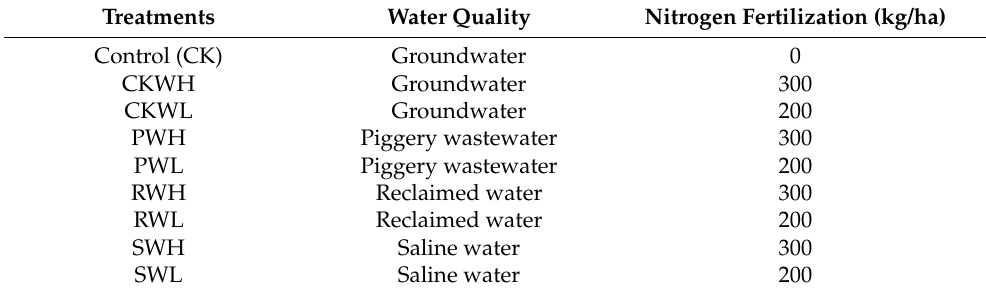
Table 1. Experimental design in this study.